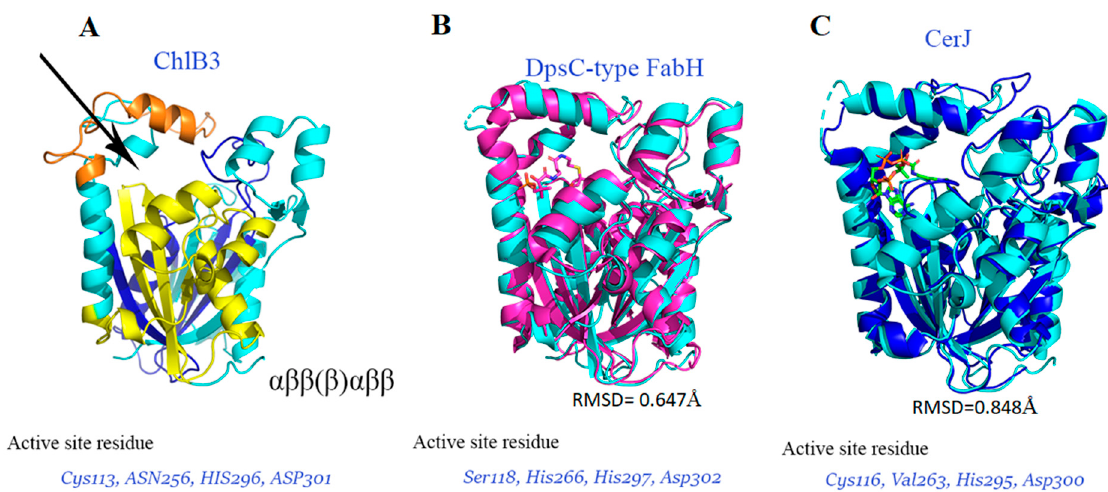
Figure 3. Comparison of the ChlB3 structure with homologous enzymes ( A ) ChlB3 structure with conserved active site residues ( B ) A superimposed structure of a structural homologous enzyme (DpsC-type FabH) exhibits the conserved active site residues. ( C ) ChlB3 was superimposed with structurally homologous enzyme CerJ, revealing the conserved residues coherent with ChlB3.